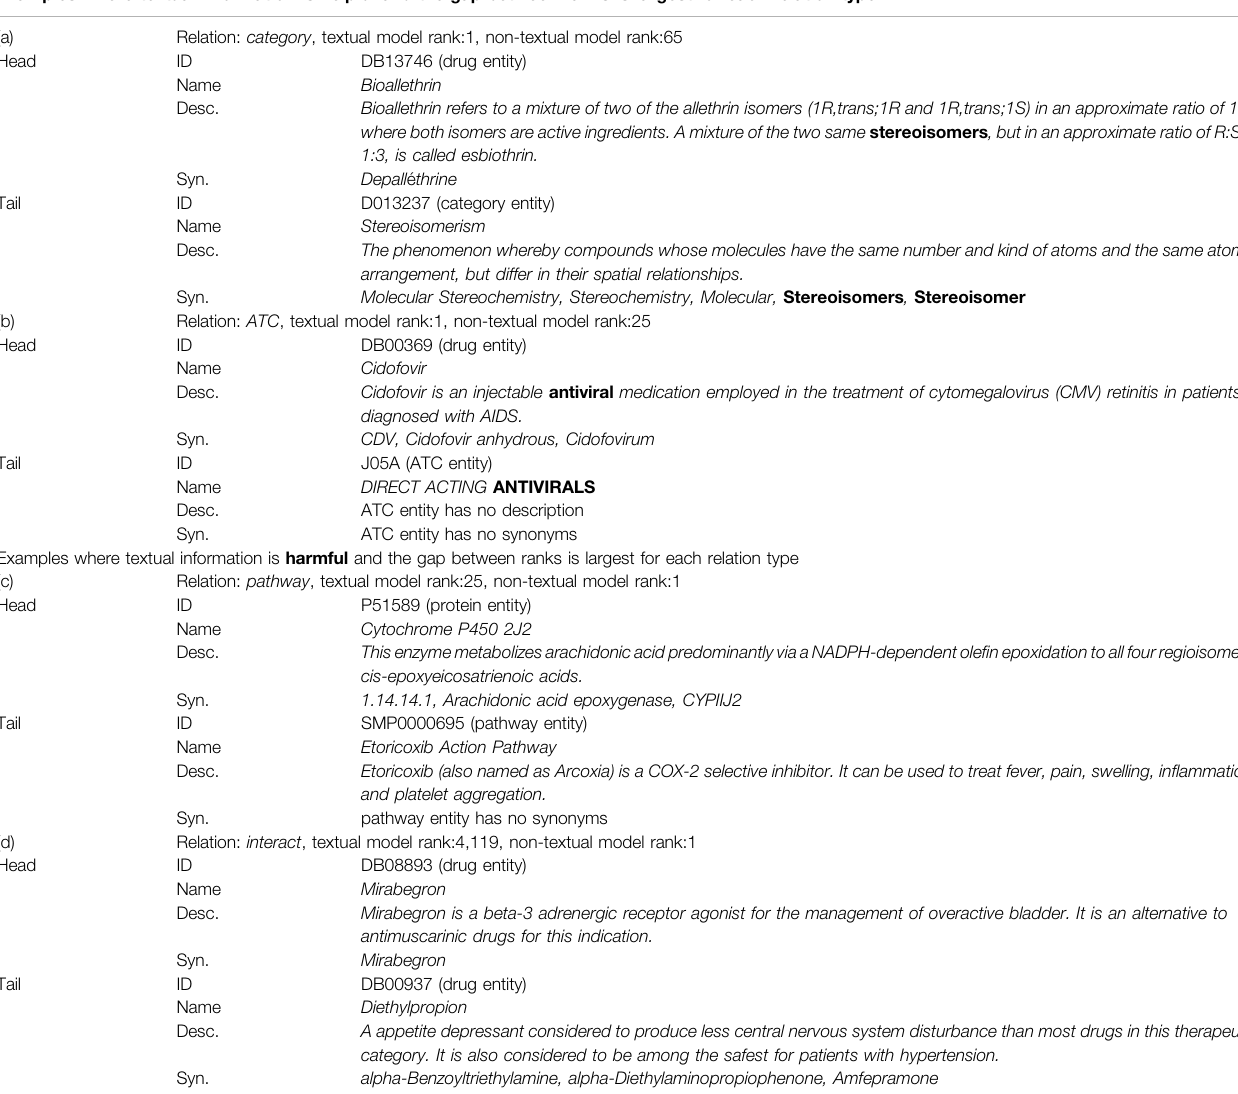
TABLE 8 | The content of the text in the exampleswhere the difference between the rank of textual model and the rank of non-textual model is largest for each relation type. The score function SimplE was used for category , ATC and pathway relation and ComplEx was used for interact relation. The Augmentation model was selected as the model with textual information. The bold is the mention common to head and tail entities. The Description and Synonyms are partly excerpted due to space limitations. Examples where textual information is helpful and the gap between ranks is largest for each relation